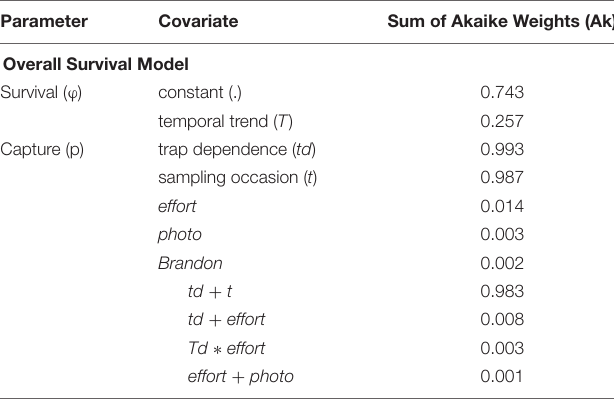
TABLE 3 | Summary of the relative importance of each covariate incorporated into the Overall Survival model. Parameter